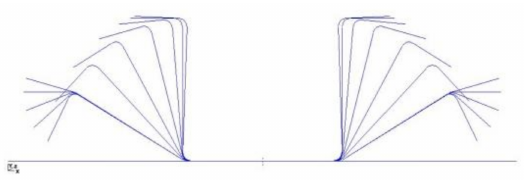
Figure 7. An inappropriate flower diagram.